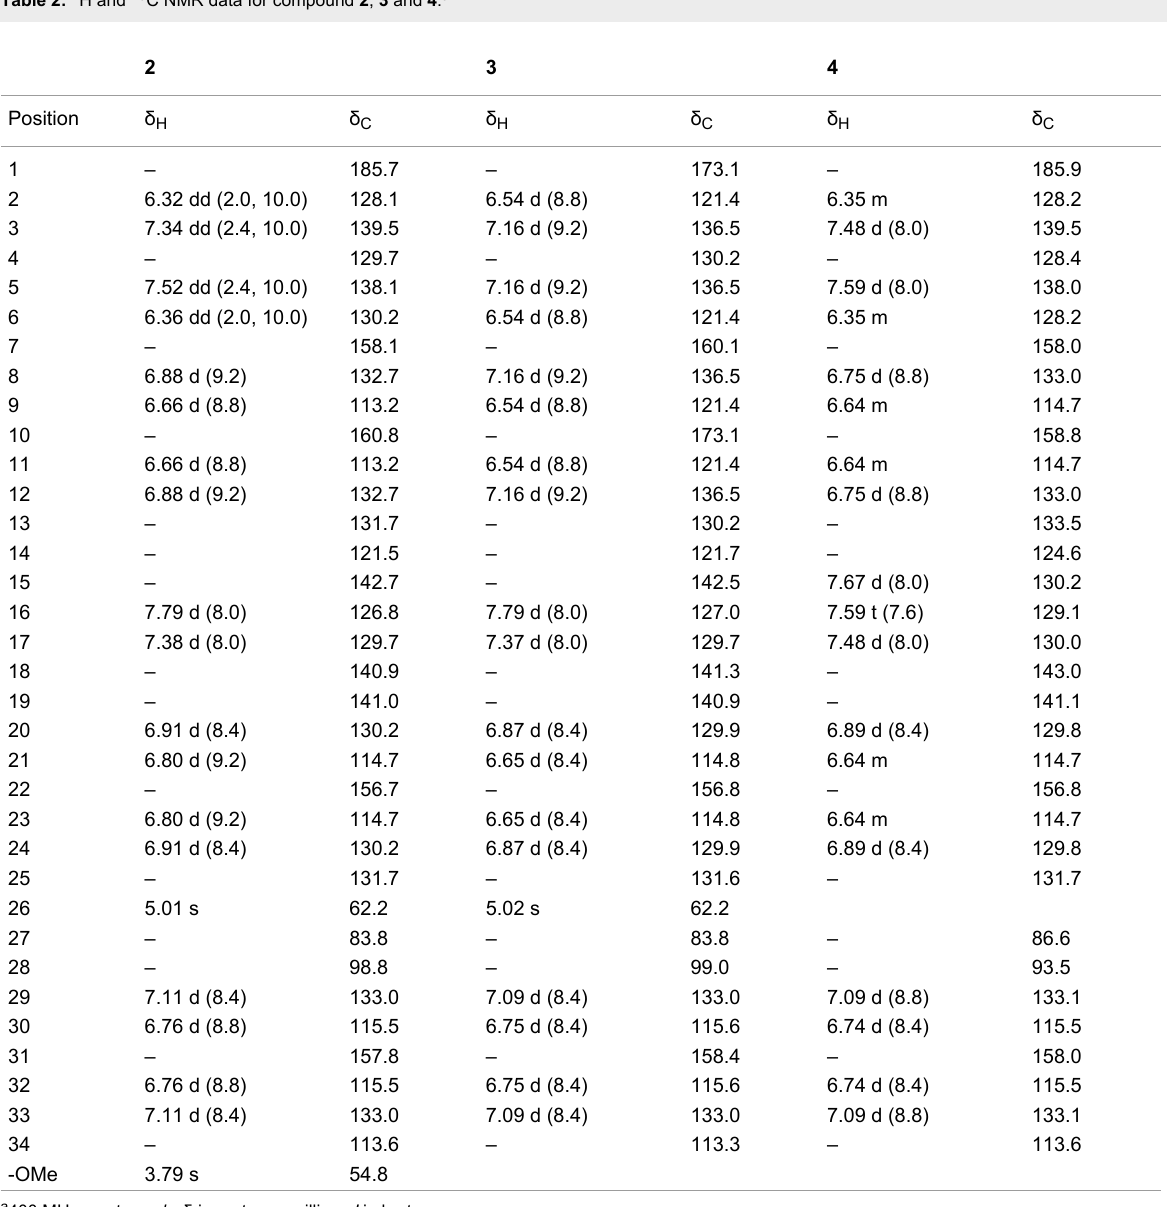
Table 2: 1 H and 13 C NMR data for compound 2 , 3 and 4 .